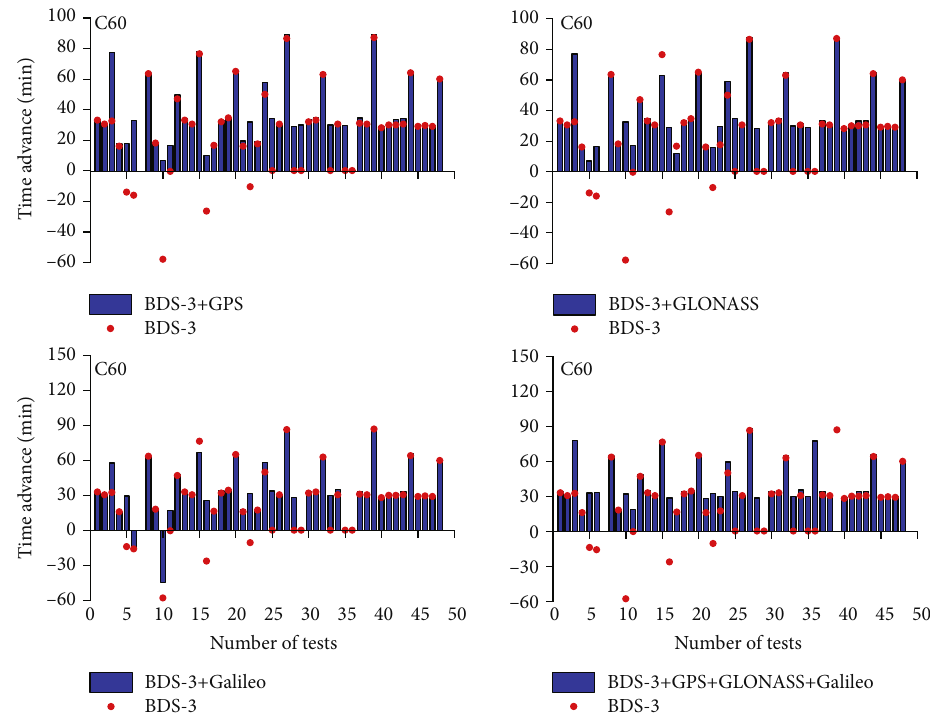
Figure 13: Comparison of detection results of C60 orbit maneuvering start times by di ff erent system